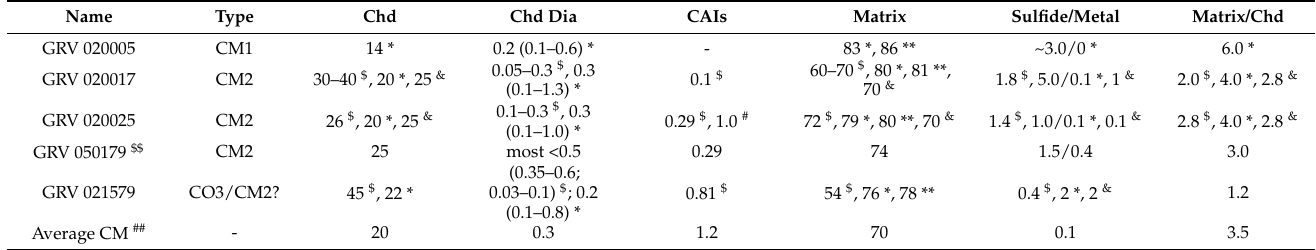
Table 2. Summary of average petrographic properties of the GRV CM chondrites.